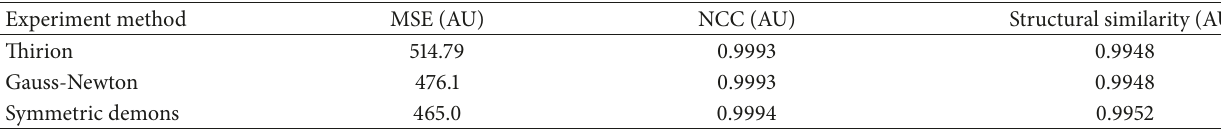
Table 4: Evaluation of registration result based on different demons driving